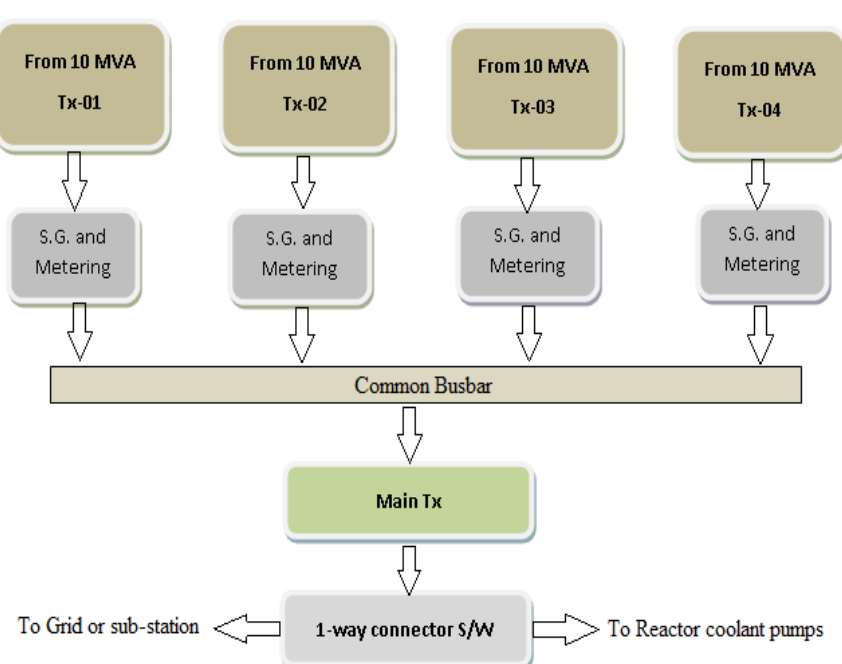
5. Arrangements of a grid tie solar plant ’s connection: